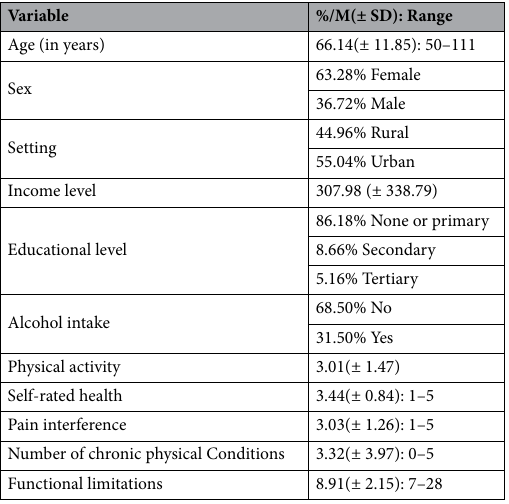
Table 1. Control variables and the characteristics of the study participants ( N = 1201). N valid frequency, M mean, SD standard deviation.